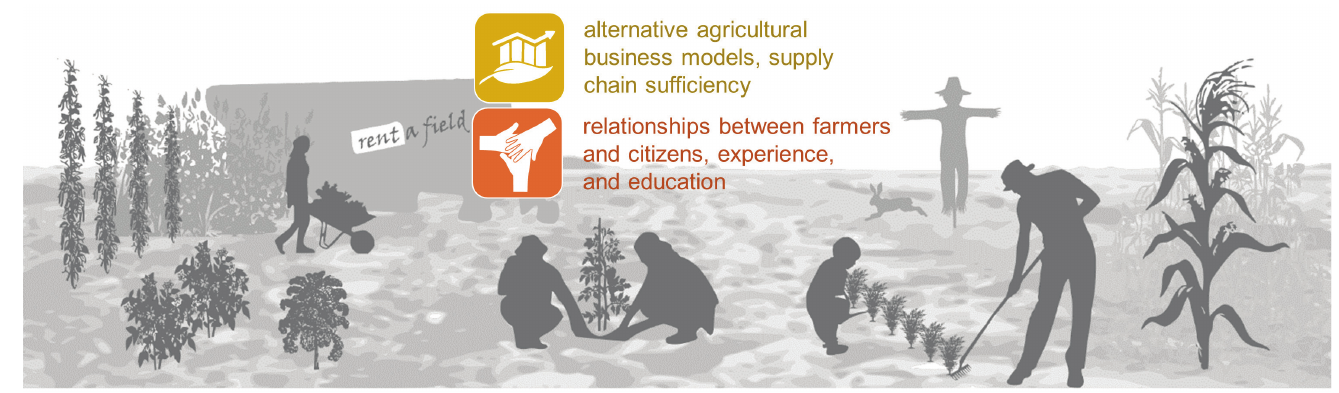
Figure 6. Illustration of productive farmland with potential key functions and benefits addressing urban